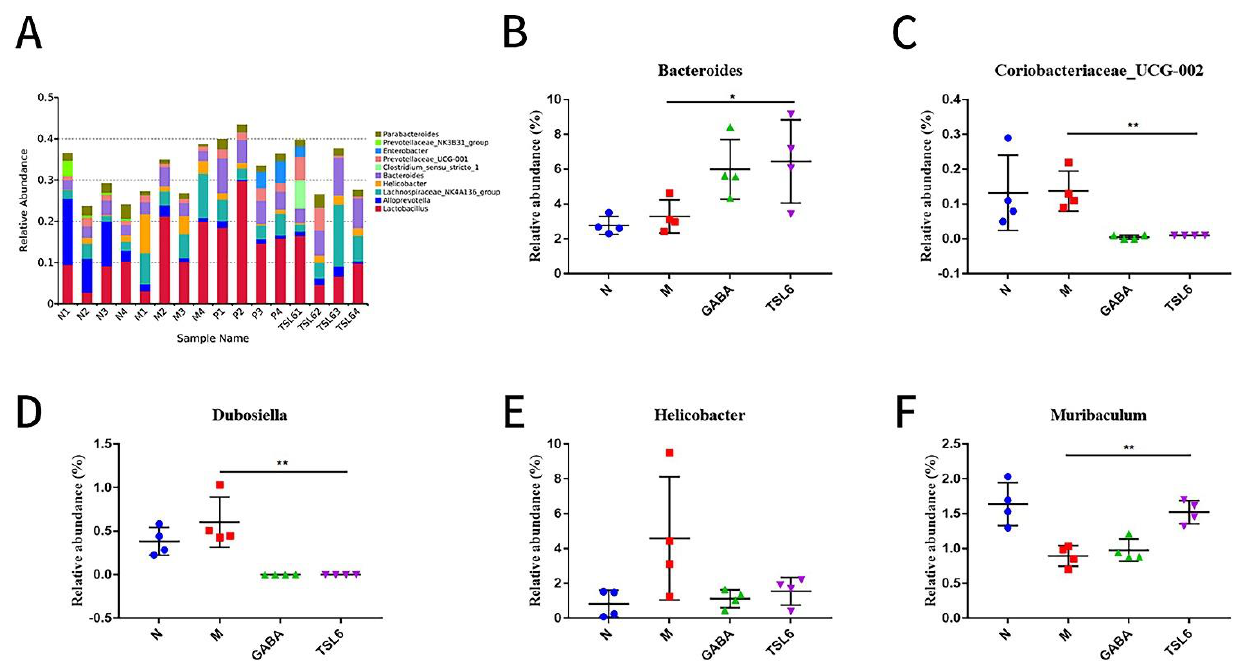
Figure 6. Regulation of the level of the intestinal microbiota of mice in each group of LZU − J − TSL6 : Comparison of the relative abundances of phylum between different groups ( A ). Relative abundances of the bacterial genera with related changes ( Bacteroides , Coriobacteriaceae − UCG − 002 , Dubosiella , Helicobacter , and Muribaculum ) ( B – F ). The bars indicate the mean ± SD ( n = 4 mice/group) * p < 0.05; ** p < 0.01.